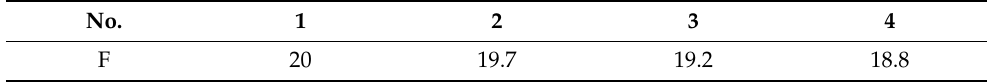
Table 3. Calculated compaction force for each